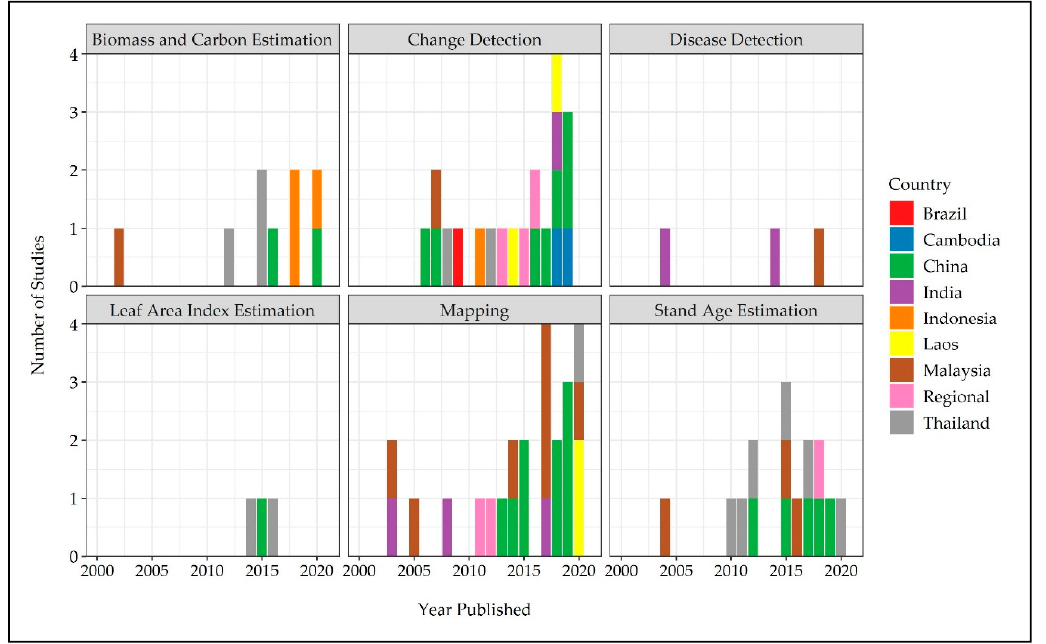
Figure 7. Distribution of the documents in each subject area based on the study area.